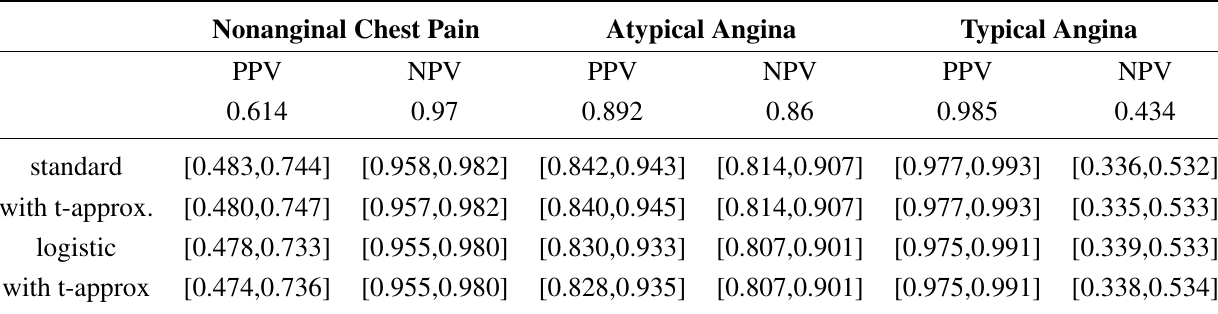
Table 5. Predictive values of CAD according to